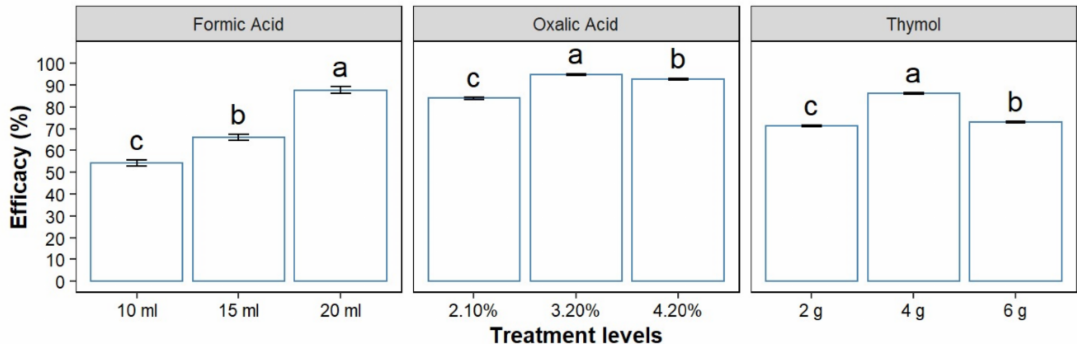
Figure 2. Efficacy of treatments against Varroa destructor . Treatments with the same letters are not significantly different; error bars signify confidence intervals